Question: Looking at the figure, what chart type is it?
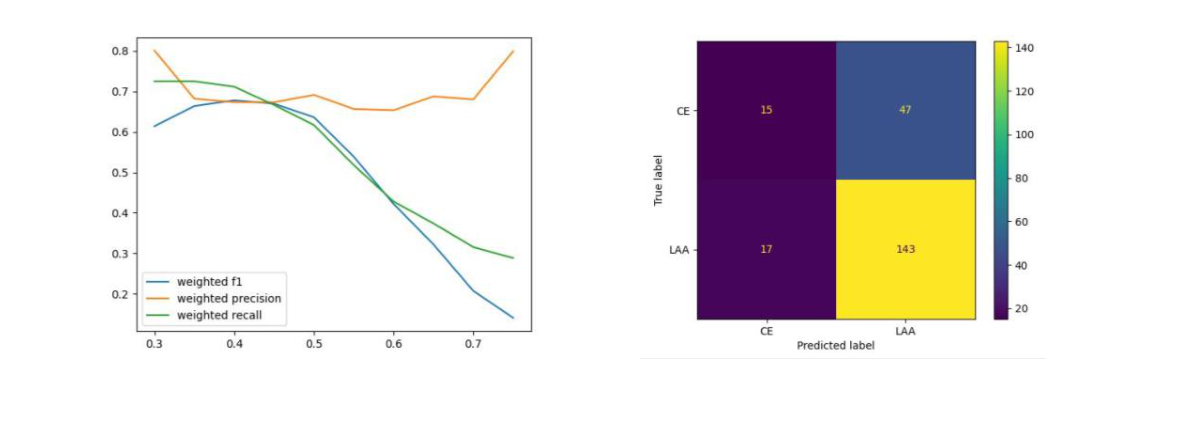
Answer: heatmap